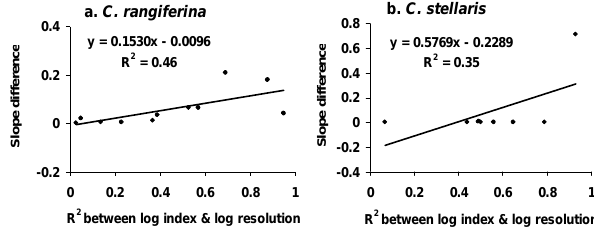
Fig. 9. The absolute difference between the slopes obtained by the Fig. 9 – The absolute difference between the slopes obtained by the wavelengths of the wavelengths of the new species specific indices C. rangiferina and new species specific indices C. rangiferina and C. stellaris , are plotted against the R 2 between C. stellaris , are plotted against the R 2 between the log of these in- the log of these indices and the log of the spatial resolution. These slopes are between the log dices and the log of the spatial resolution. These slopes are be- reflectance and log spatial resolution obtained at the 1080 nm and 1480 nm range for C. tween the log reflectance and log spatial resolution obtained at the rangiferina index, and 900 nm and 1470 nm for the C. stellaris index (n = 11, significance value < 1080nm and 1480nm range for C. rangiferina index, and 900nm 0.05, critical value R 2 > 0.28). and 1470nm for the C. stellaris index ( n = 11, significance value < 0 . 05, critical value R 2 > 0 .